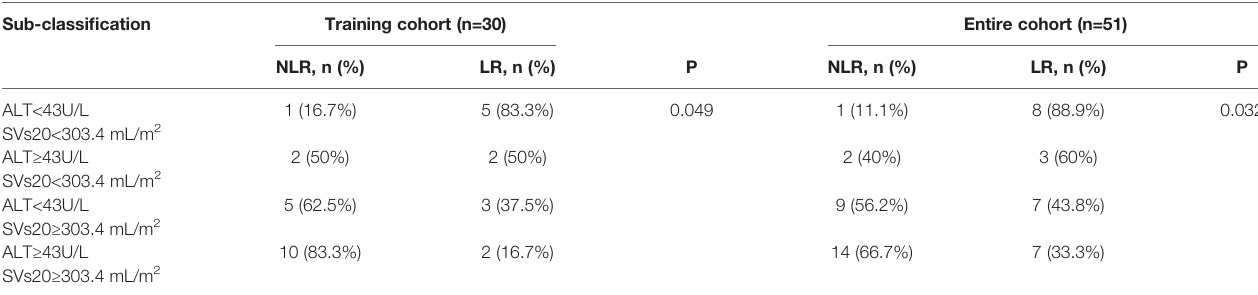
TABLE 2 | Risk Group Sub-classi fi cation based on ALT and SVs20. Sub-classi fi